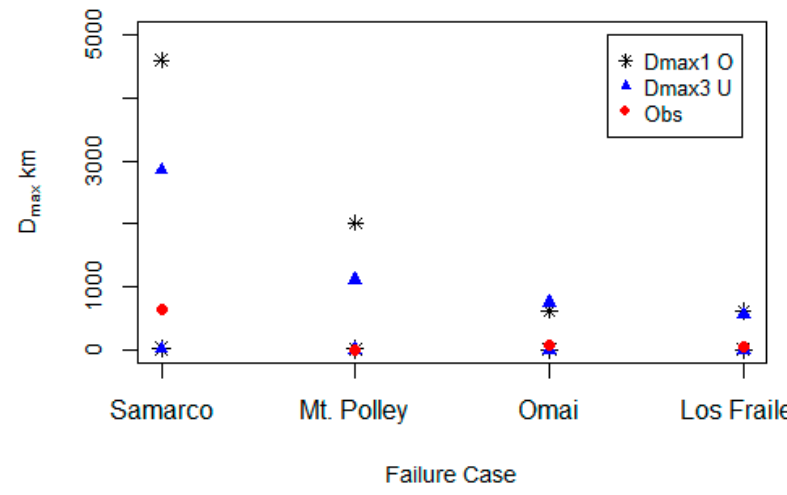
Figure 2. Examples of prediction intervals from D max . 1 O (Rico’s original equation), D max .3 U and the observations for D max of past failures (obs).